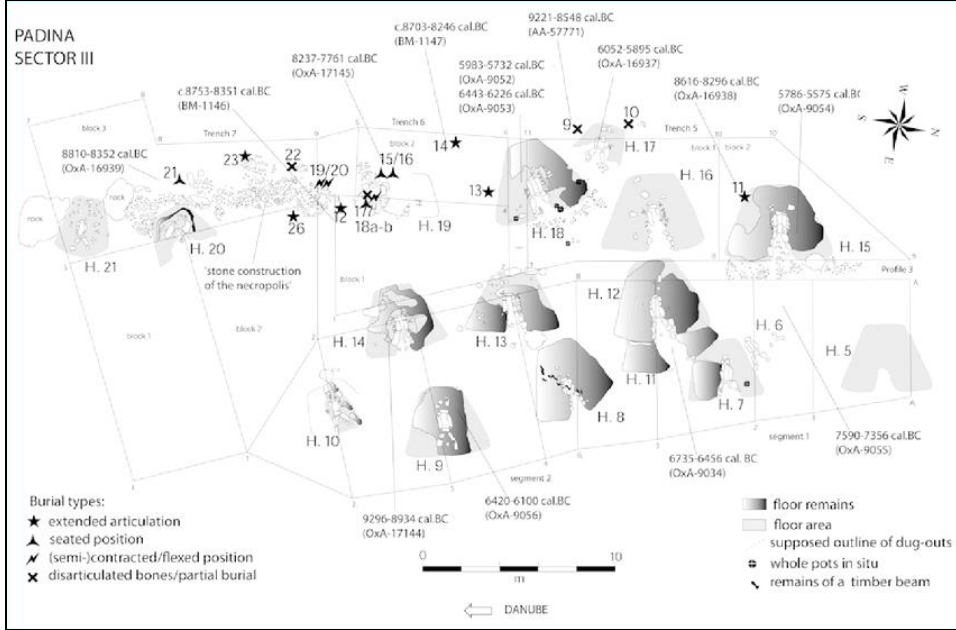
Figure 26. Arrangement of the base of houses in the settlement of Padina - Gospodjin Vir